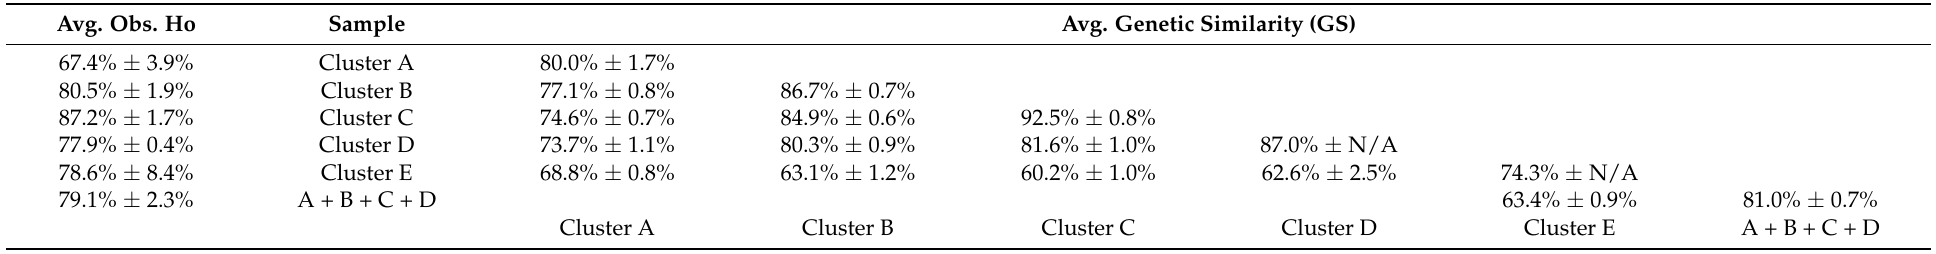
Table 6. Average genetic similarity of clusters identified through the construction of the UPGMA dendrogram, and average observed homozygosity (Avg. Obs. Ho) The standard error is also